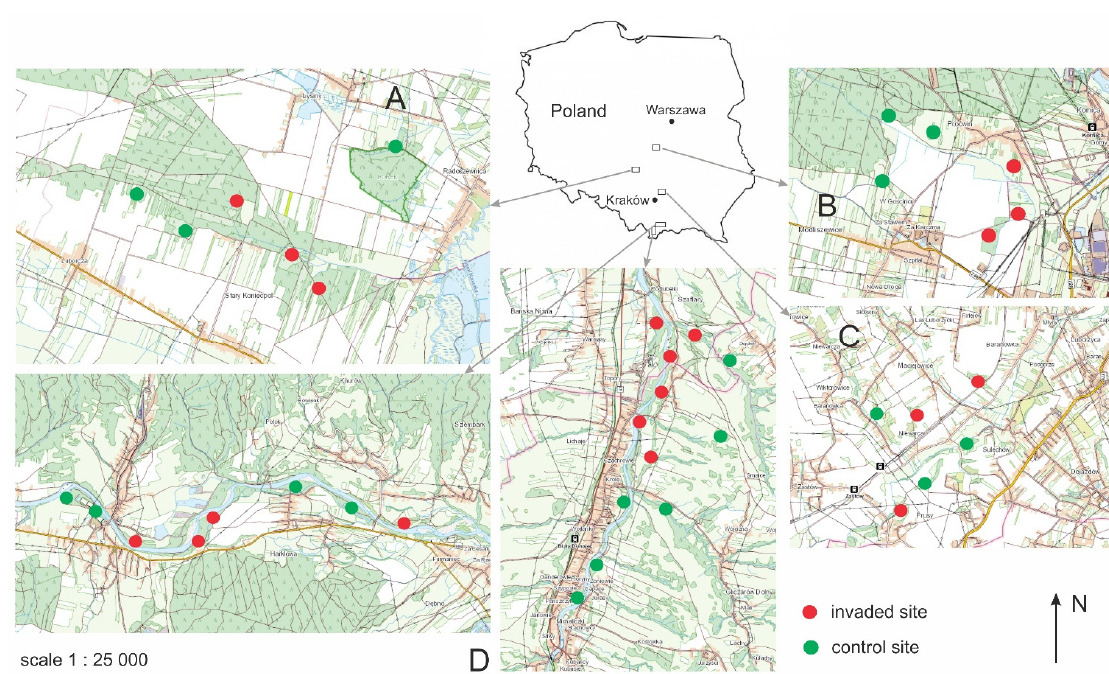
Figure 1. Map of the study sites in various regions ( A–D , for more details see Section 2.1. Study Sites) of south-eastern Poland with Caucasian hogweeds (N = 19, red circles) and control (N = 19, green circles). Free background source: geoportal.gov.pl (accessed on 2 March 2022).